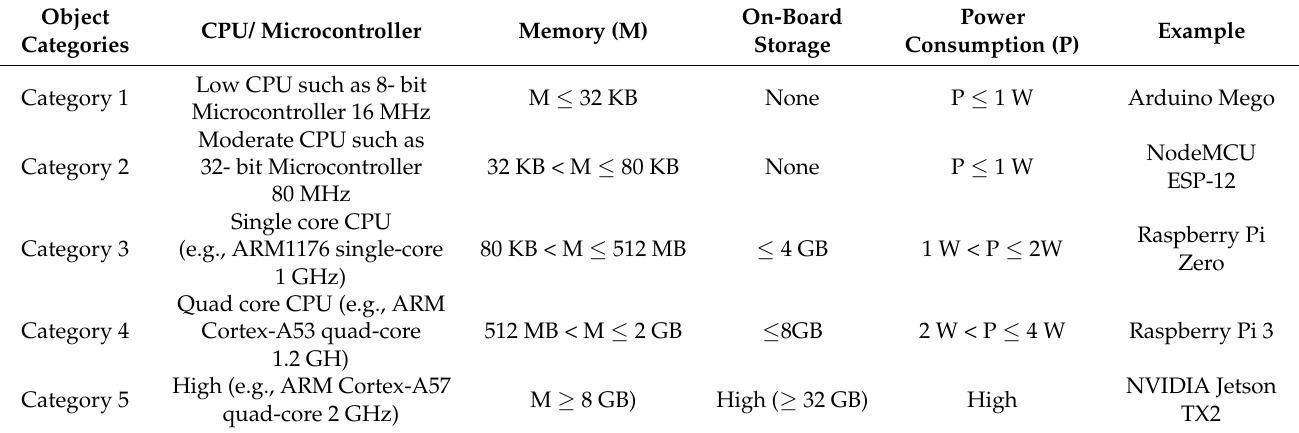
Table 5. Classification of IoT objects based on their hardware